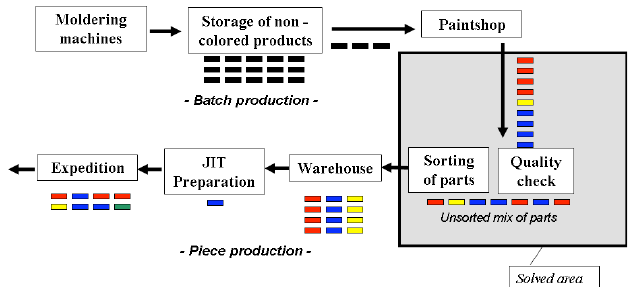
Fig. 1. Schema of production